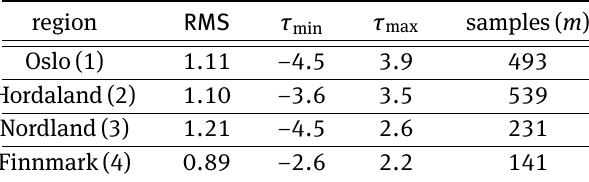
Table 3: Root-Mean-Squares (RMS) of τ i are shown below for the marked regions of Fig. 1 (NMA2013v30). Observations closer than ∆ min = 10 km to each prediction point are not used to make the prediction (or determine the local statistics) at that